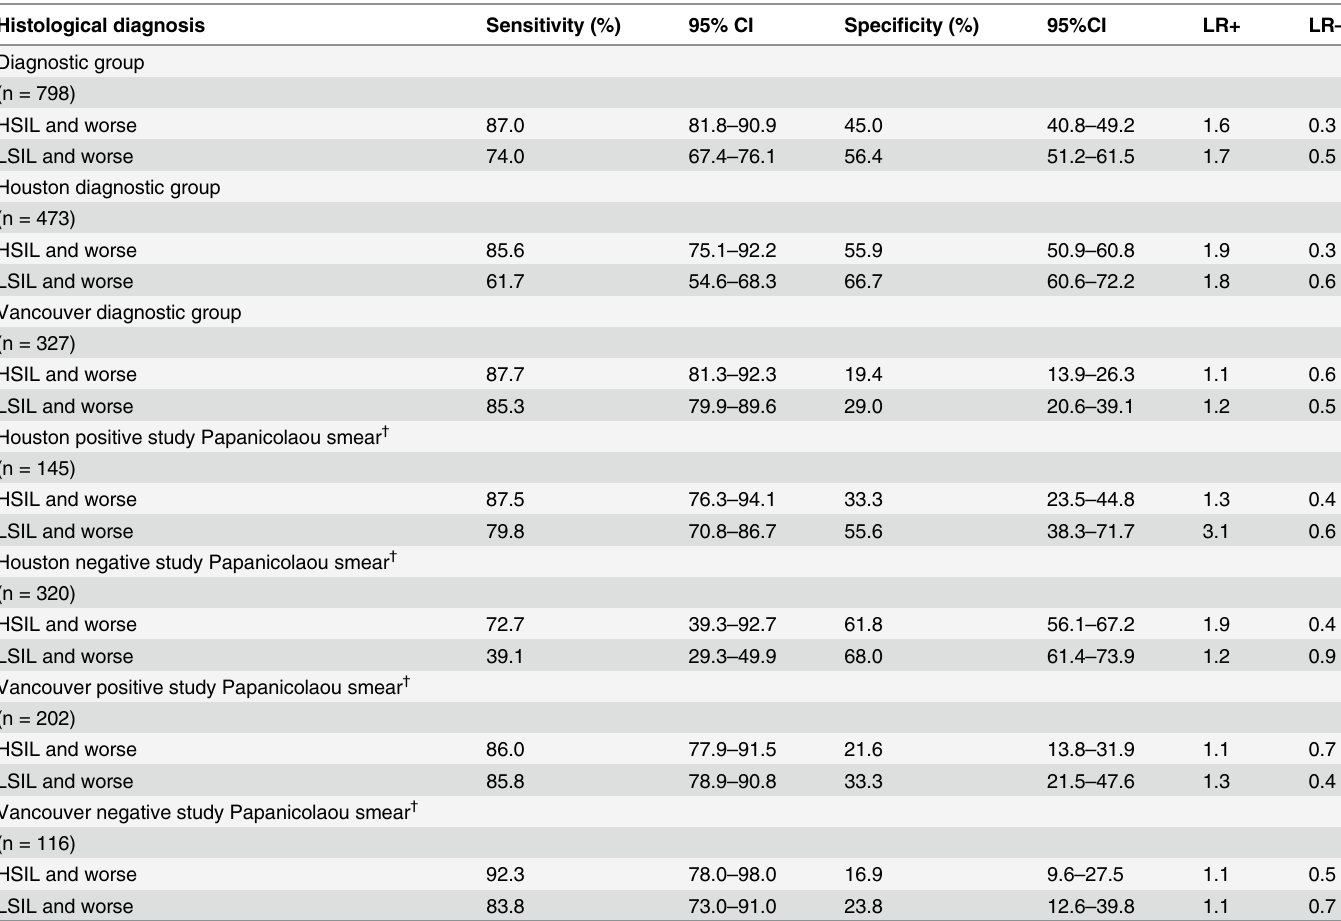
Table 2. Summary of Results: Colposcopy sensitivities, specificities, positive and negative likelihood ratio values. Histological